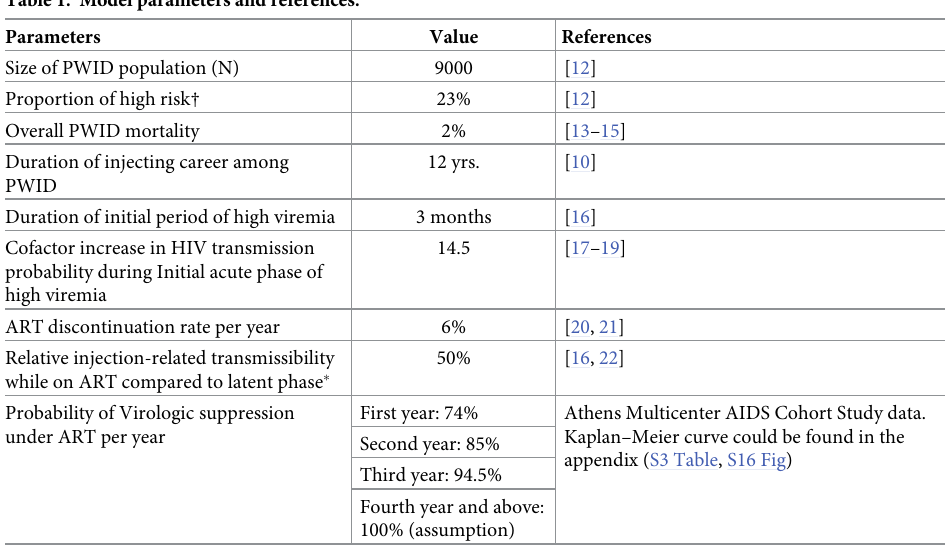
Table 1. Model parameters and